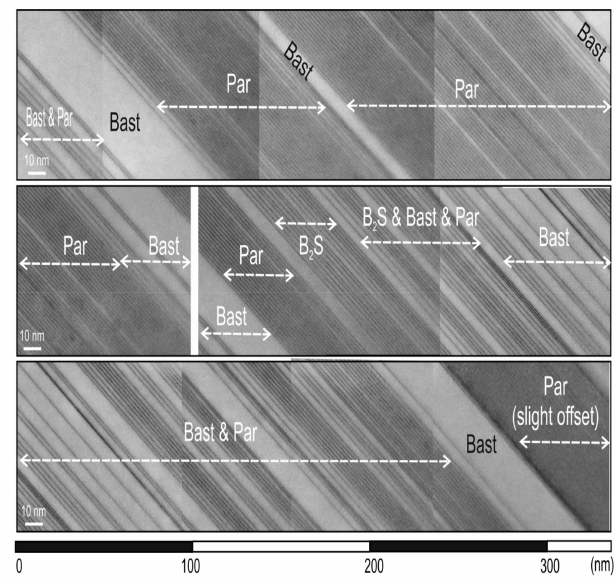
Figure 10. Short-range stacking disorder over a ~1 µ m-long profile across lamellar intergrowths from area 6 (marked on Figure 3f); specimen tilted down to [10 − 10] zone axis. The HAADF STEM imaging shows 100 nm periods of bastnäsite and parisite with gradational changes to intergrowths between 2- and 3-species (as marked). Bast—bastnäsite; Par—parisite.